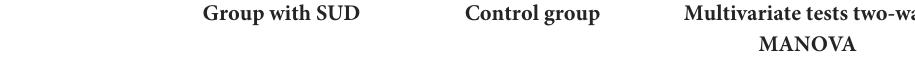
TABLE 3 Mean comparison of group with SUD and control group by sociodemographic factors on shame and guilt using multivariate analysis.